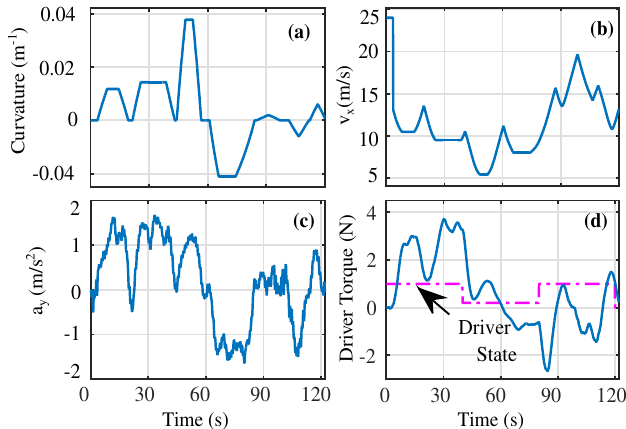
Figure 4. The road and driver input conditions: ( a ) Curvature; ( b ) Longitudinal Velocity; ( c ) Lateral Acceleration; ( d ) Driver input